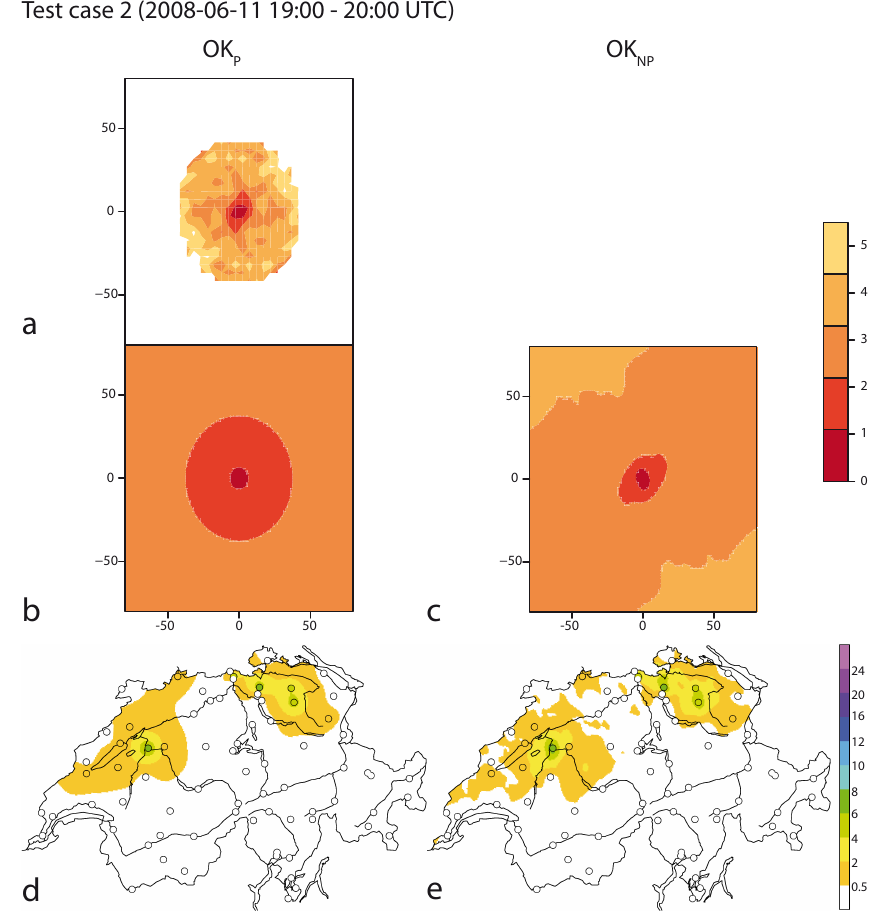
Fig. 8. As Fig. 6 but for test case 2.